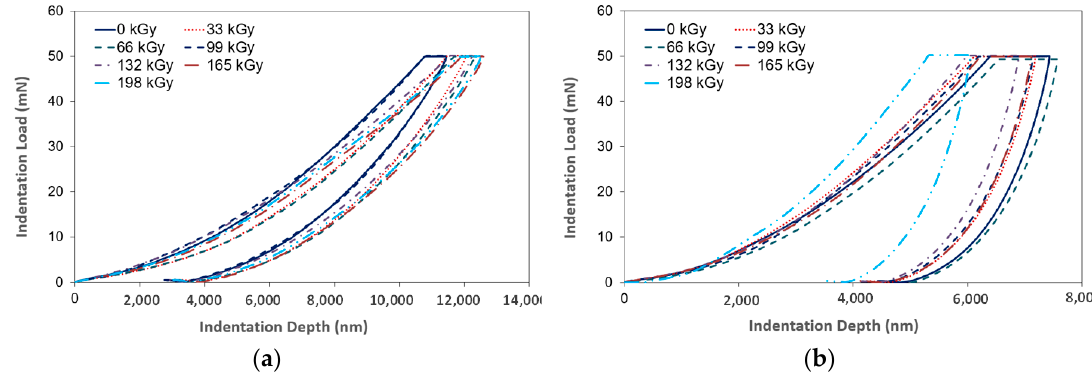
Figure 5. Indentation curve (indentation load vs. indentation depth): ( a ) LDPE; ( b ) HDPE.